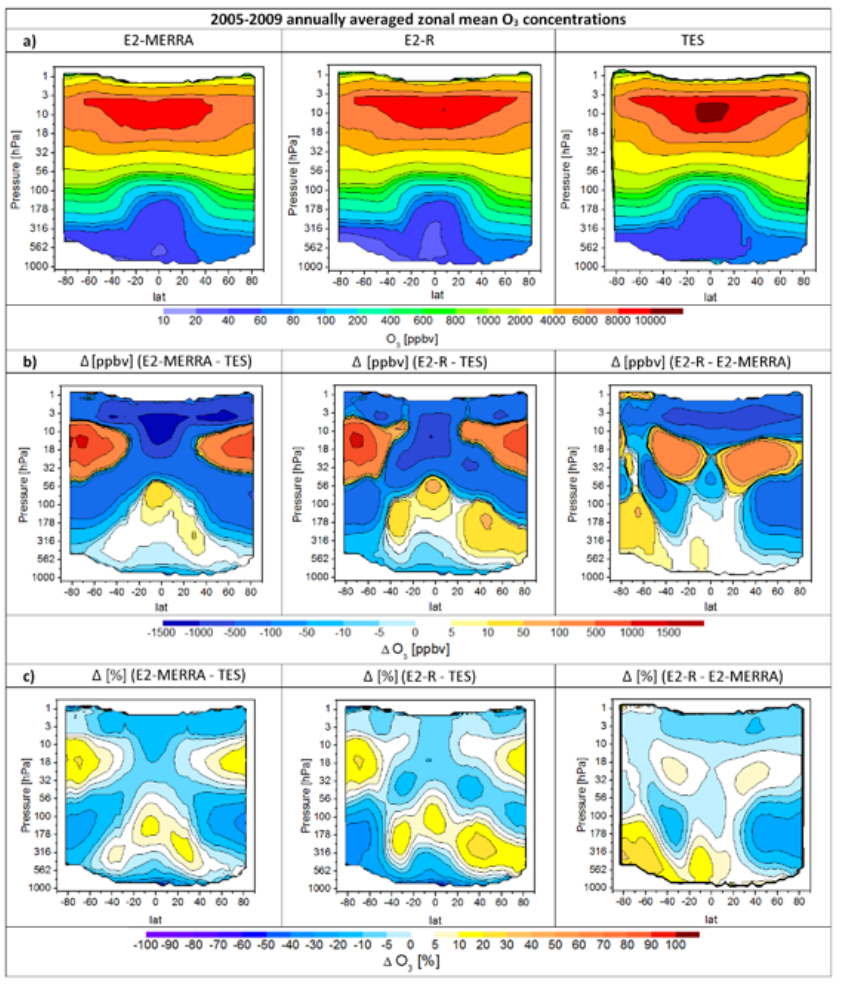
Fig. 3. Zonal mean ozone (ppbv) in the MERRA-nudged run (top left), the ACCMIP/CMIP5 E2-R run (top center) and in TES observations (top right). Differences between the model runs and TES and between the two model runs are shown in the second row in ppbv and in the third row in